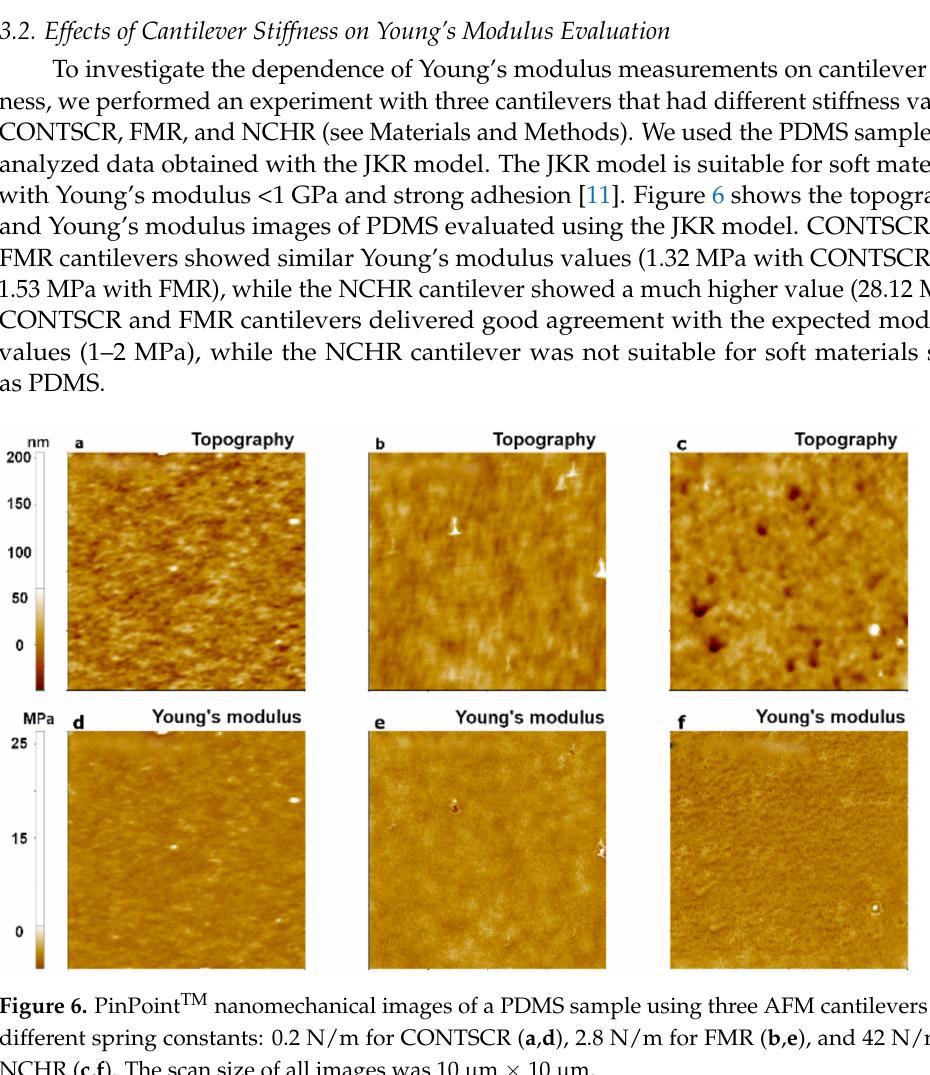
Figure 5. Young’s modulus for each polymer sample using different contact mechanics models in the case of PDMS ( a ), LDPE ( b ) and PS ( c ).